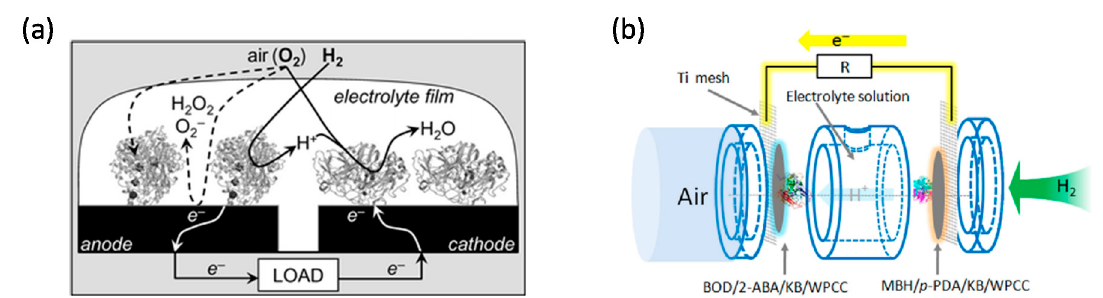
Figure 3. Schematic representations of enzymatic biofuel cells (EBC). ( a ) EBC comprises of graphite electrodes modified with O 2 -tolerant MBH of R. metallidurans CH34 (anode) and fungal laccase (cathode) in aqueous electrolyte exposed to 3% H 2 in air. Reprinted with the permission from ref [166]. Copyright (2006), The Royal Society of Chemistry. ( b ) A dual gas diffusion membrane-free H 2 /air powered EBC comprises of a [NiFe]-MBH (anode) and a bilirubin oxidase (cathode). Reprinted with the permission from ref [168]. Copyright (2016), Elsevier B.V.